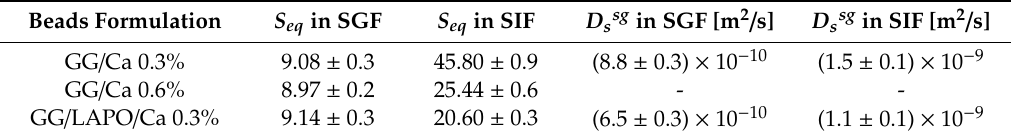
Table 2. Swelling degree at equilibrium S eq (measured after 24 h) and e ff ective solvent di ff usion coe ffi cient D ssg of di ff erent bead formulations in Simulated Gastric Fluid (SGF; HCl 0.1 M)